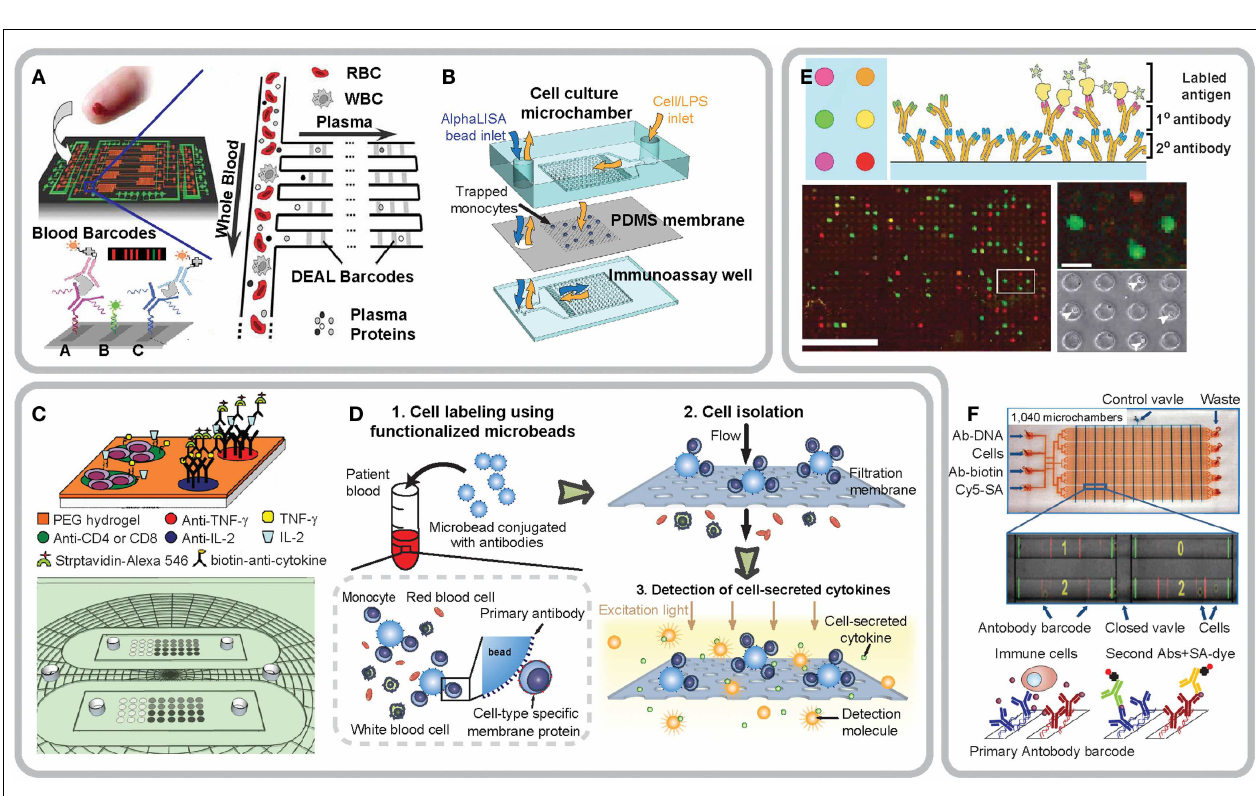
(2008) by permission ofThe Royal Society of Chemistry. (D) Schematic of isolation and immunophenotyping of subpopulations of immune cells